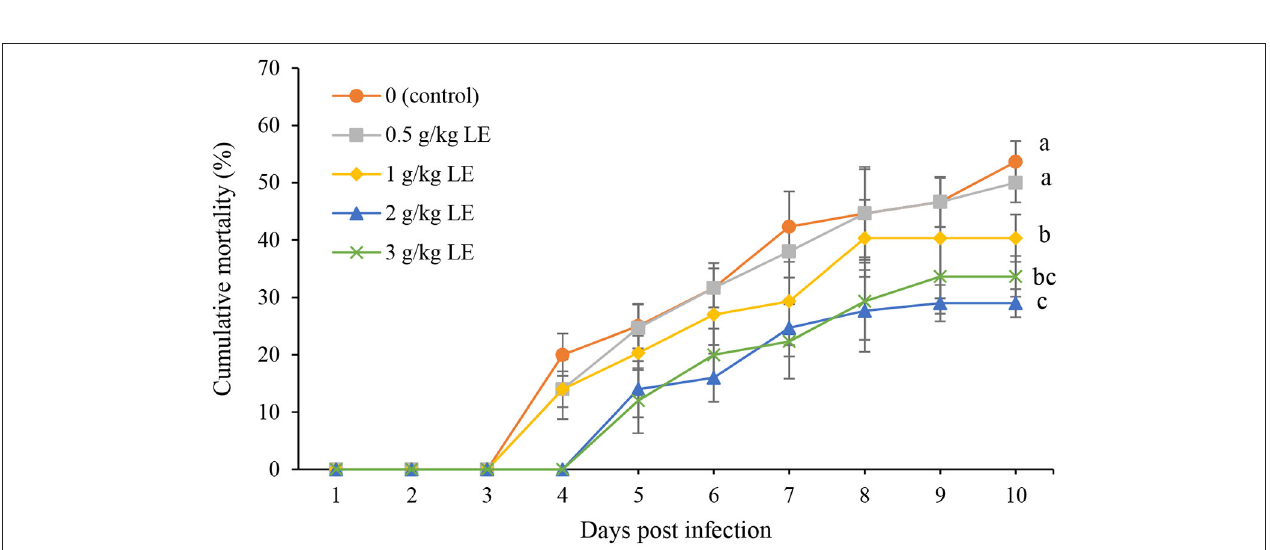
FIGURE 4 | The cumulative mortality of rainbow trout fingerlings fed with different levels of licorice extract (LE) supplemented diets after experimentally challenged with Yersinia ruckeri for 10 days. Bars assigned with the same superscripts are not significantly different ( P > 0.05). Values are presented as the mean ± SD ( n = 3).